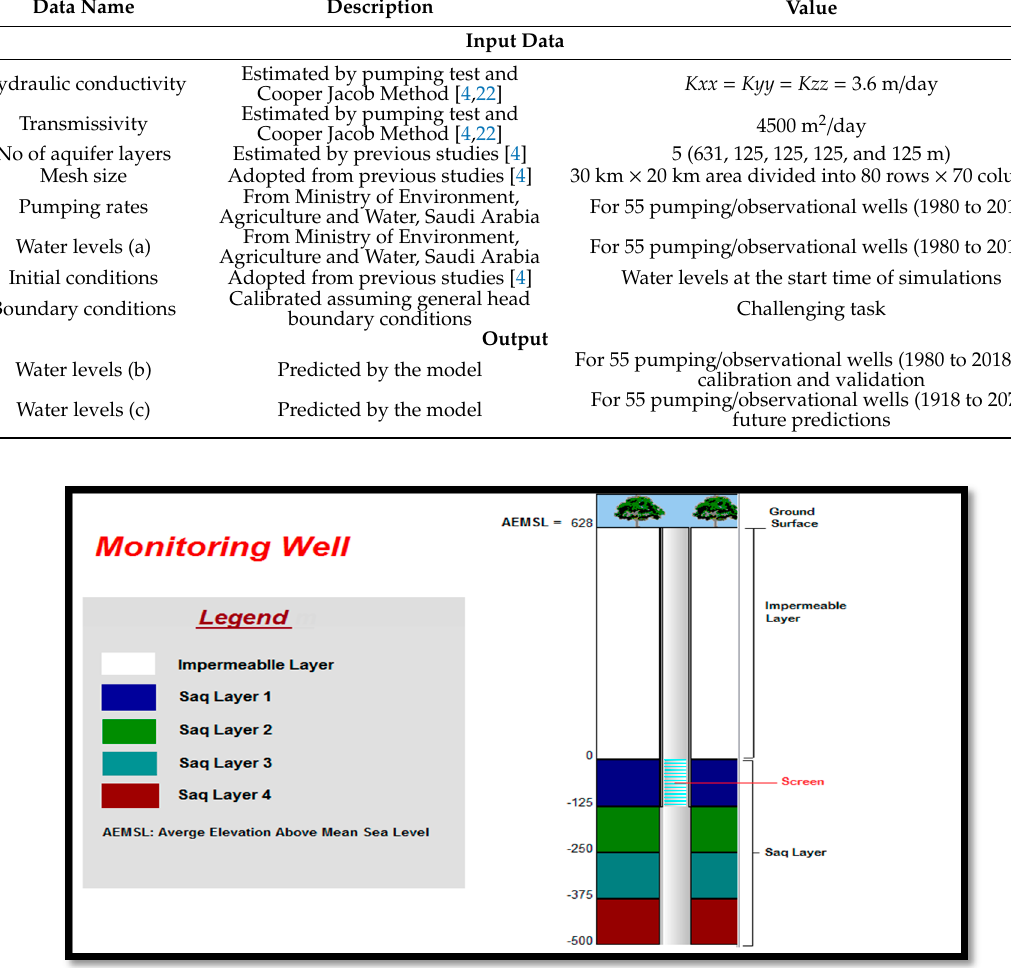
Table 2. Input and output data for MODFLOW.